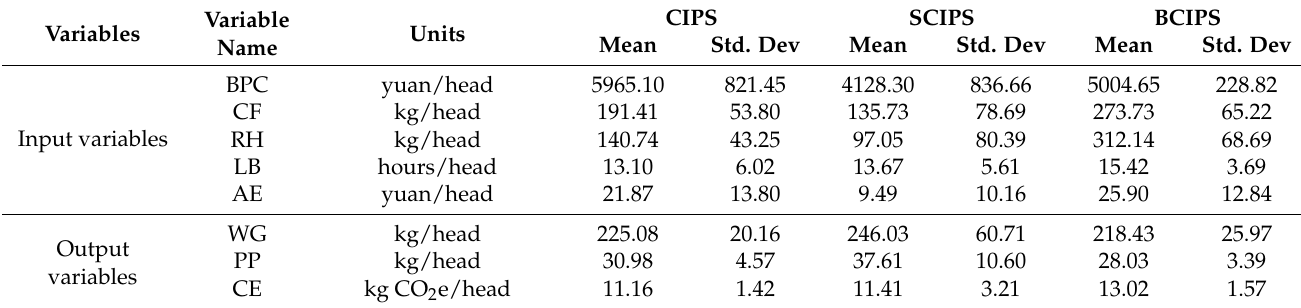
Table 2. Description of the Statistics for Variables Used in the Production Efficiency Analysis (Data from 218